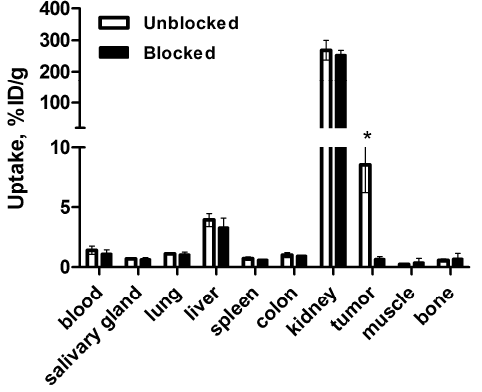
Figure 6. In vivo specificity of [ 68 Ga]Ga-DFO-ZEGFR:2377 accumulation in A431 xenografts in mice 3 h after injection. In the blocked group, receptors were saturated by preinjection of large excess of anti-EGFR antibody cetuximab 24 h before the experiment. The data were presented as the average (n = 4 for blocked group and n = 7 for unblocked group) and SD. Asterisk (*) marks significant ( p < 0.0005) difference.